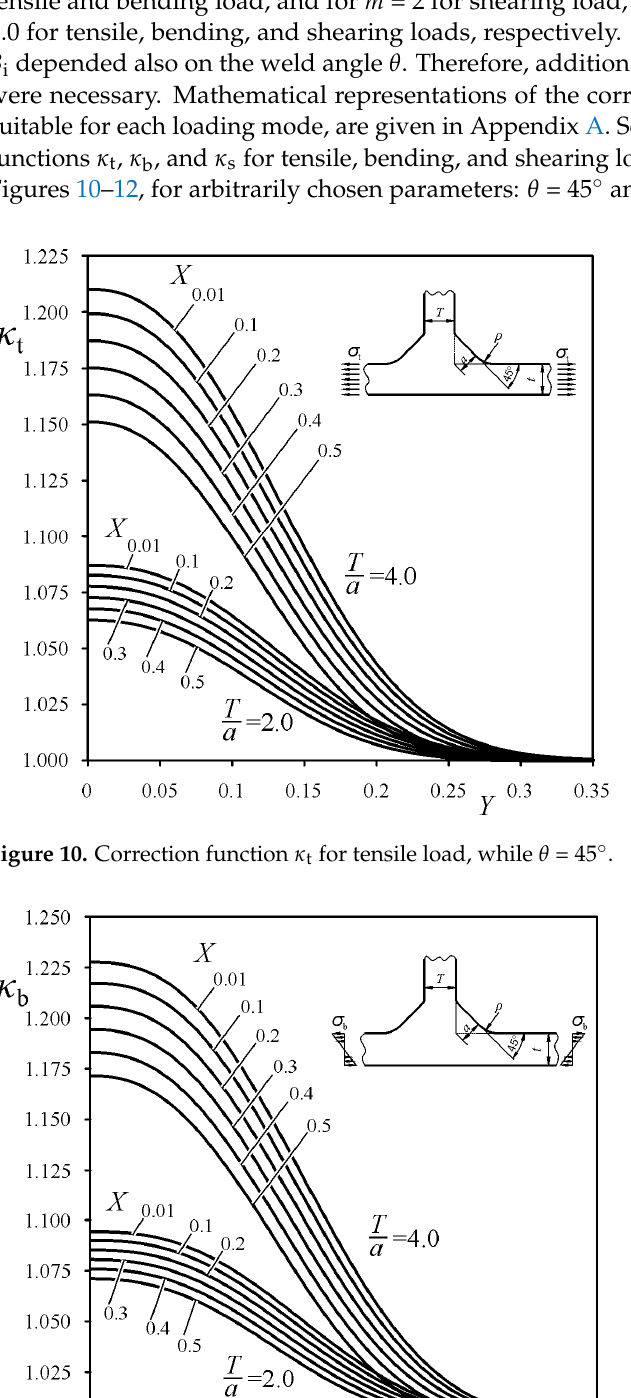
Figure 11. Correction function κ b for the bending load while θ = 45°.